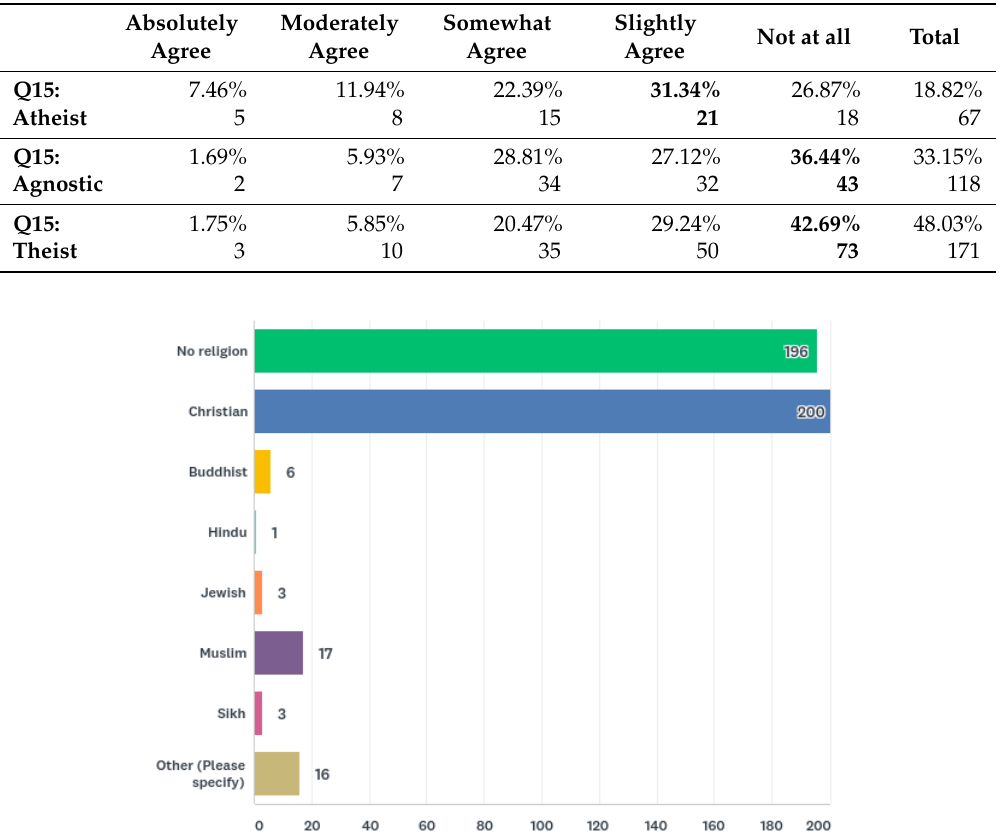
Figure 3. Question 16: What is your Religion? ( N = 442).